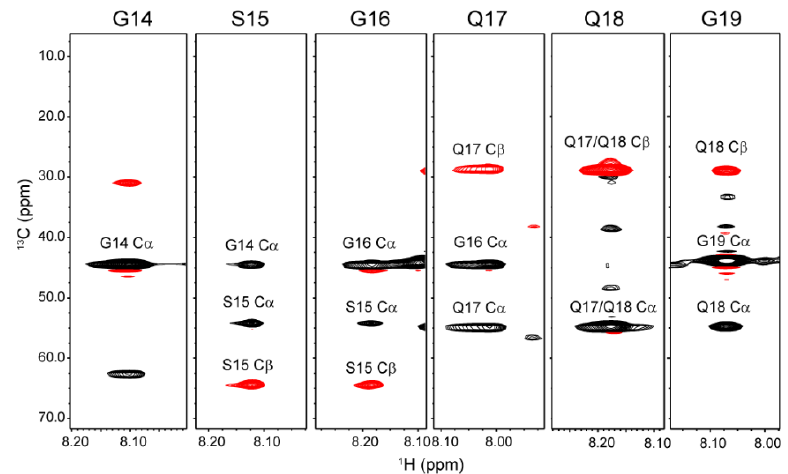
Figure 3 . The strip plots of the 3D triple resonance HNCACB spectrum of U-[ 13 C, 15 N] labeled RSP in FA collected at 298 K, 600 MHz. Selected 15 N planes with 1 H- 13 C correlations are displayed with antiphased 13 Cα (black) and 13 Cβ (red) cross-peaks from the corresponding amino acids and previous amino acids. Table 1 . 1 H, 13 C, and 15 N chemical shifts (in ppm) of amino acid residues in the 32-residue repetitive sequence of RSP in FA . Amino acids are described with three letter codes.